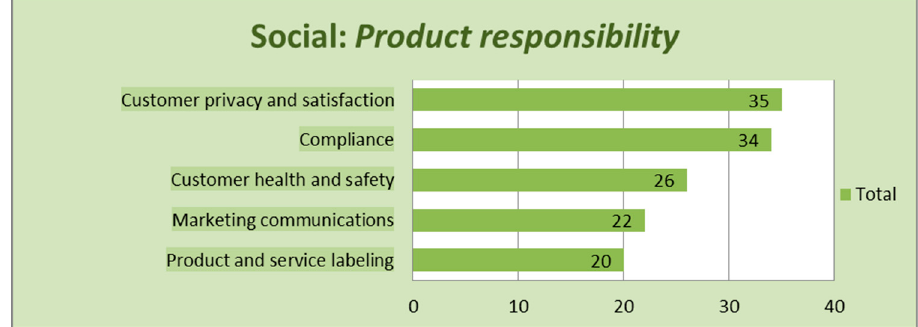
Figure 4. Tallies of occurrence of the social sustainability indicators from the product responsibility category.